Question: Which visualization type does this figure use?
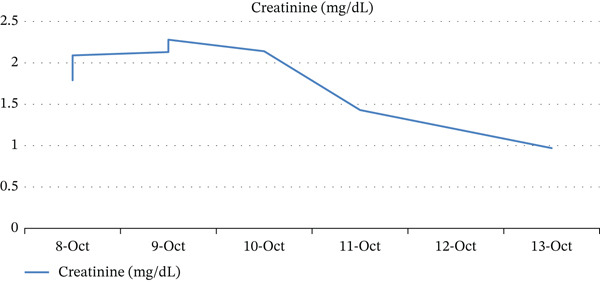
Answer: line